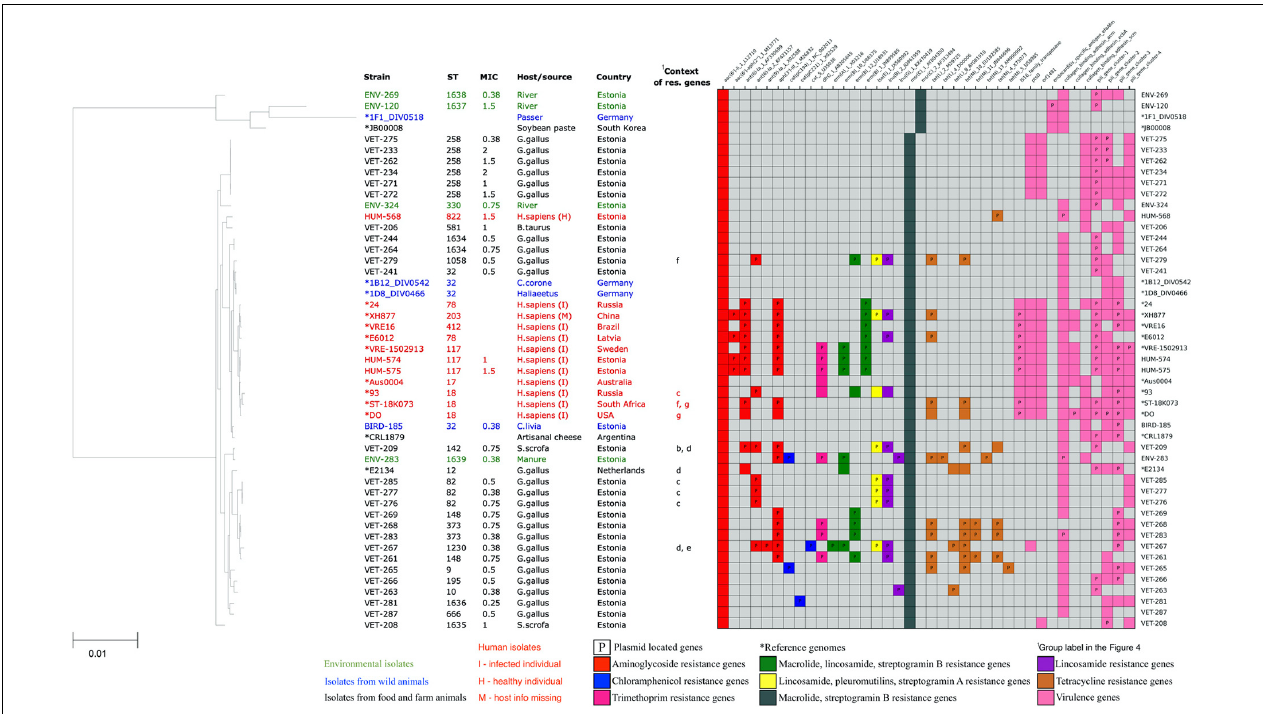
FIGURE 3 | Core-genome phylogenetic tree of our collected 34 Enterococcus faecium isolates and 16 reference genomes with the distribution matrix of the antimicrobial resistance and virulence genes detected in their whole-genome